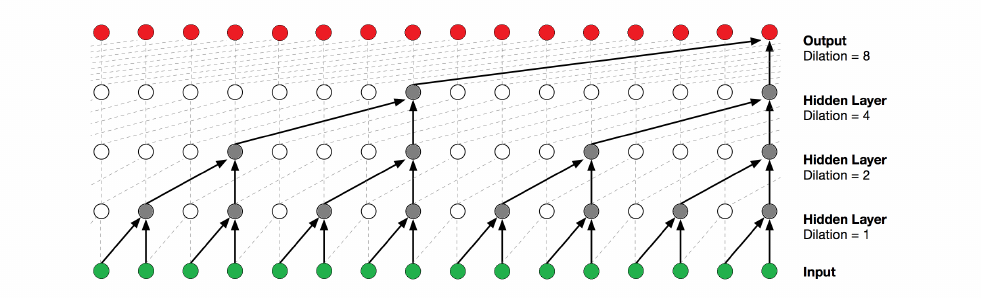
Figure 5. Visual illustration of a causal TCN [61]. This TCN has a block size of 1, a dilation list (1,2,4,8) (i.e., dilation factor 8), and a kernel size of 2. This results in a receptive field of 2 · 1 · 8 =